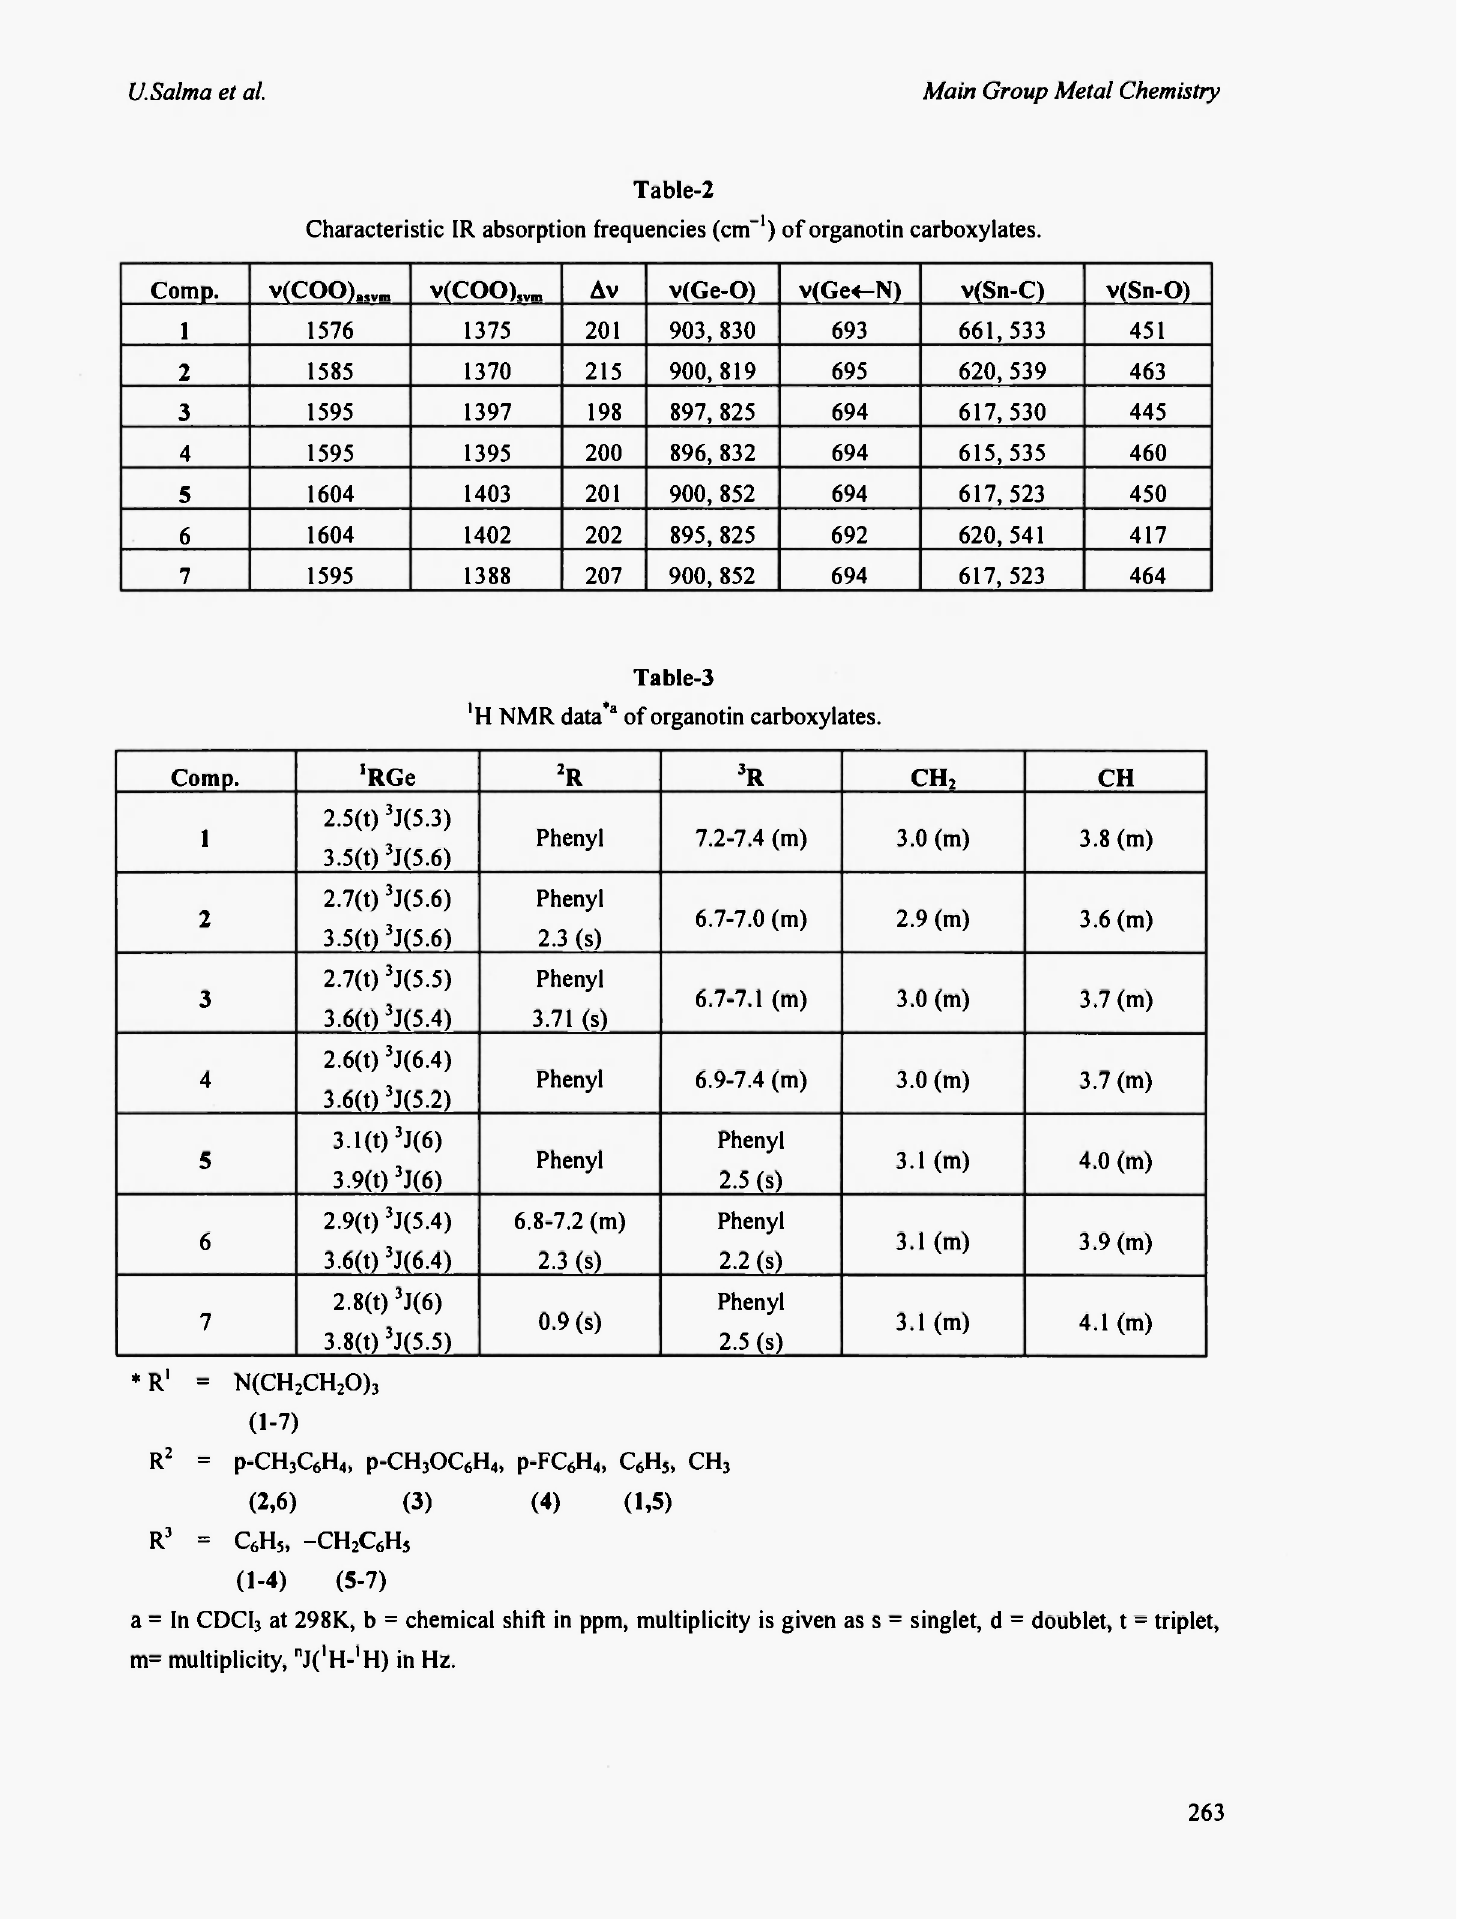
Characteristic IR absorption frequencies (cm"') of organotin carboxylates.